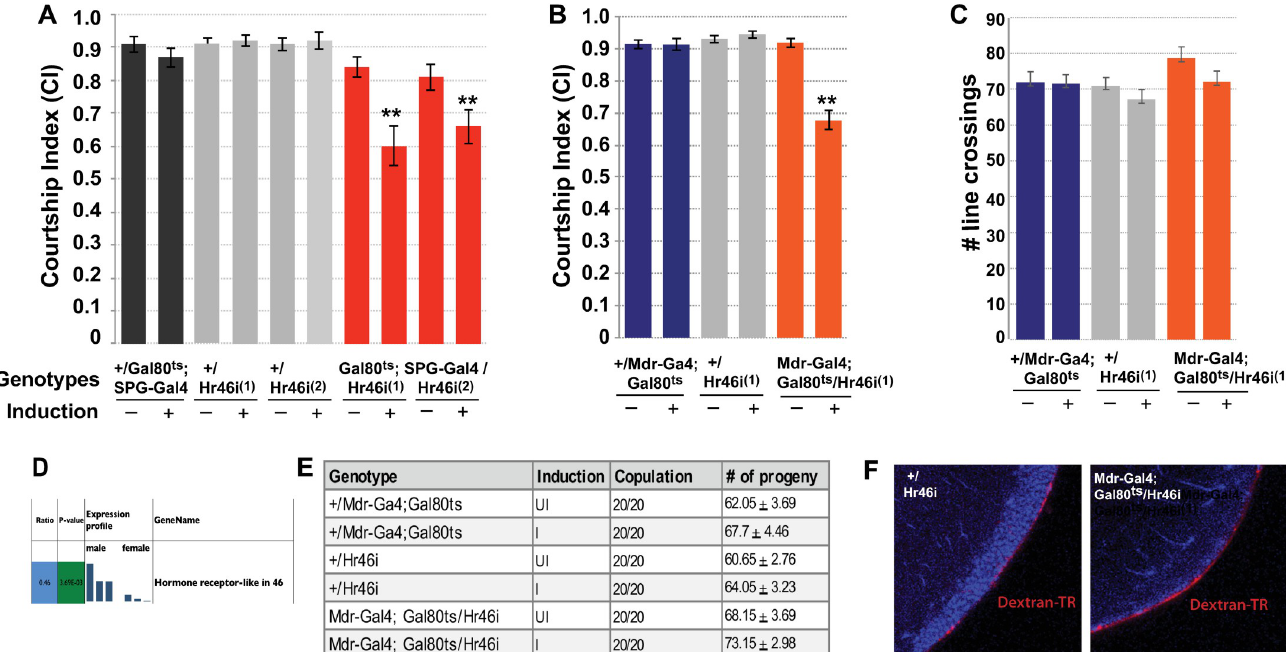
Fig 3. Knockdown of Hr46/Hr3 in the BBB of mature males reduces courtship. (A-C) Graphs show the courtship index CI (fraction of time males spend courting during the observation period) ± SEM (A, B), or the performance of males in a control activity assay (# of line crossings ± SEM) (C) of the indicated genotypes. N = 20. Data were analyzed by ANOVA followed by Tukey multiple comparisons (p < 0.05). Indices that are significantly different from the controls are marked by asterisks. UAS-Hr46i (abbreviated as Hr46i ) expression is restricted by the presence of tubP-Gal80 ts (abbreviated as “ Gal80 ts ”) at 18˚C (induction -). Placement of 5-day-old males at 32˚C for 16 hours (induction +) releases the Gal80 inhibition and leads to the expression of RNAi. (A) Conditional expression of two different UAS-Hr46-RNAi transgenes (1-line 27253 and 2-line 27254) using SPG-Gal4 significantly reduces male courtship. (B) Conditional expression of UAS-Hr46i (27254) using Mdr-Gal4 in adult males similarly reduces courtship in comparison to controls. The controls are +/ tubP-GAL80 ts ;+/SPG-Gal4 and +/Mdr-Gal4; +/tubP-GAL80 ts , respectively, as well as +; +/UAS-Hr46 RNAi . (C) The activity of the mutants as measured by number of line crossings is not lower than in control flies. Some variation in activity is likely caused by genetic background. (D) Hr46/Hr3) RNA is preferentially expressed in males. (E) Males with identical genotypes and induction regimen as in A-C were combined with a mature adult Canton-S virgin and scored for copulation. N = 20. All males copulated (20/20) and produced similar numbers of progeny. (F) Blood–brain barrier integrity is not compromised in Mdr-Gal4/ UAS-Hr46-RNAi males. Experimental and controls flies were injected with 10 kDa TR-Dextran (red) and dye penetration into or exclusion from the brain was examined by confocal microscopy. The brain nuclei are stained with DAPI. A tight BBB is indicated by the demarcated red line on the surface of the brain indicating exclusion of TR-dextran from the brain of Mdr-Gal4/UAS-Hr46-RNAi males. Flies were injected and processed in parallel and imaged with identical settings. Magnification = 63x.